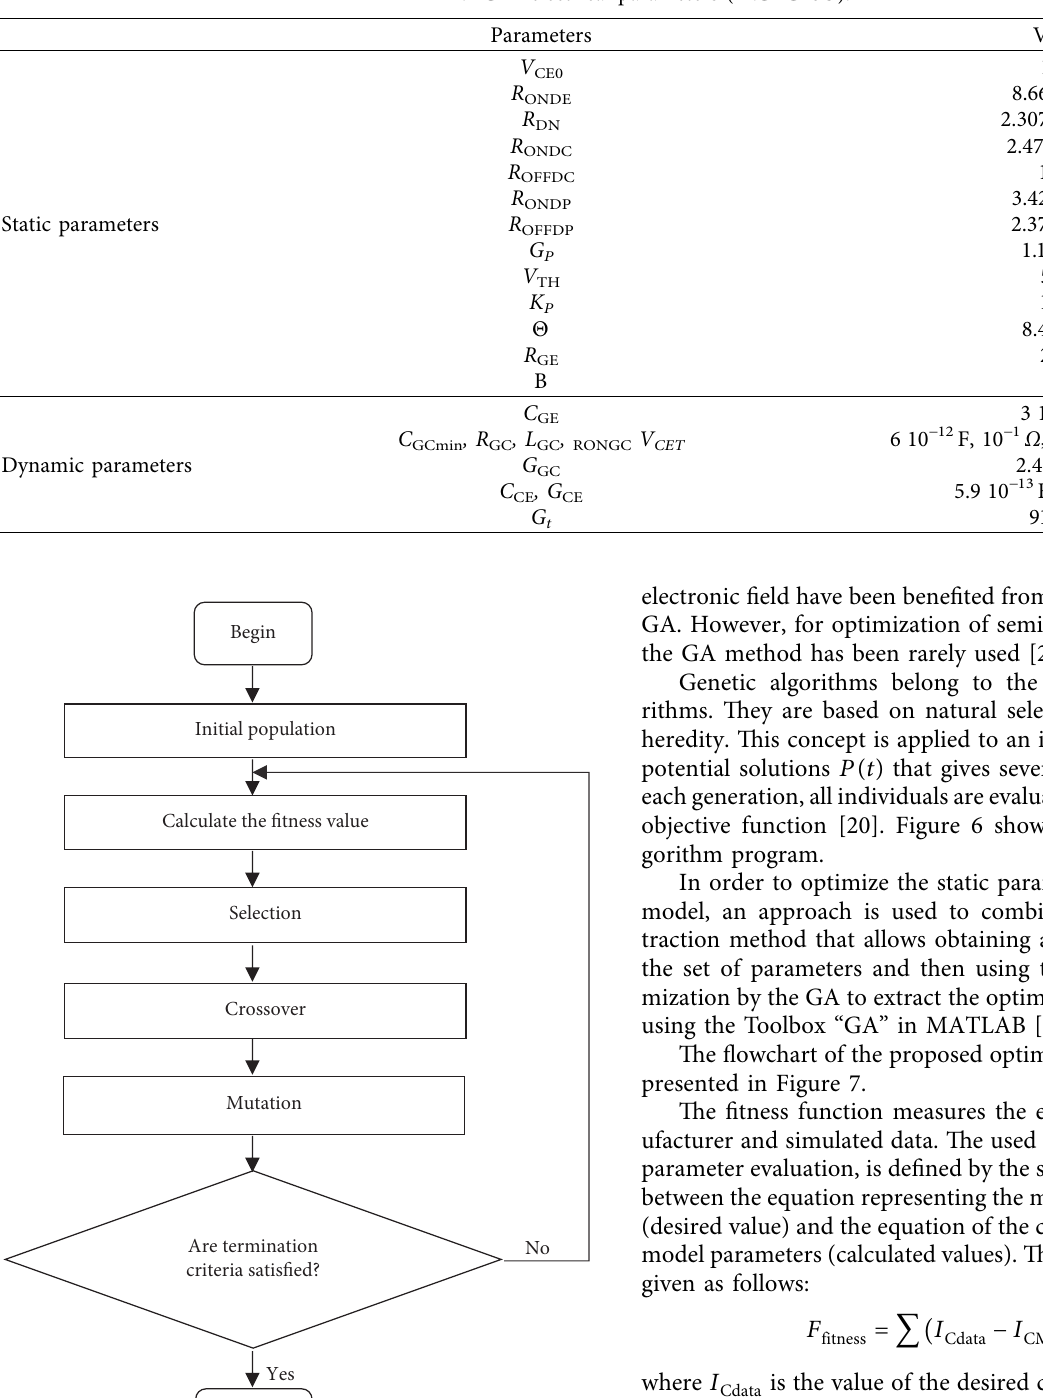
Table 1: IGBT electrical parameters